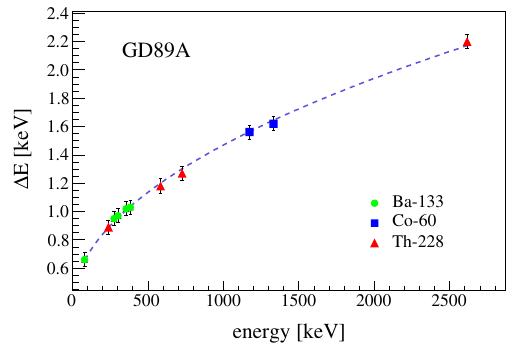
Fig. 8 Energy resolution in terms of FWHM as function of energy for detector GD89A. For the fit function only the two energy resolution terms Δ E sf and Δ E el were considered, while Δ E cc was